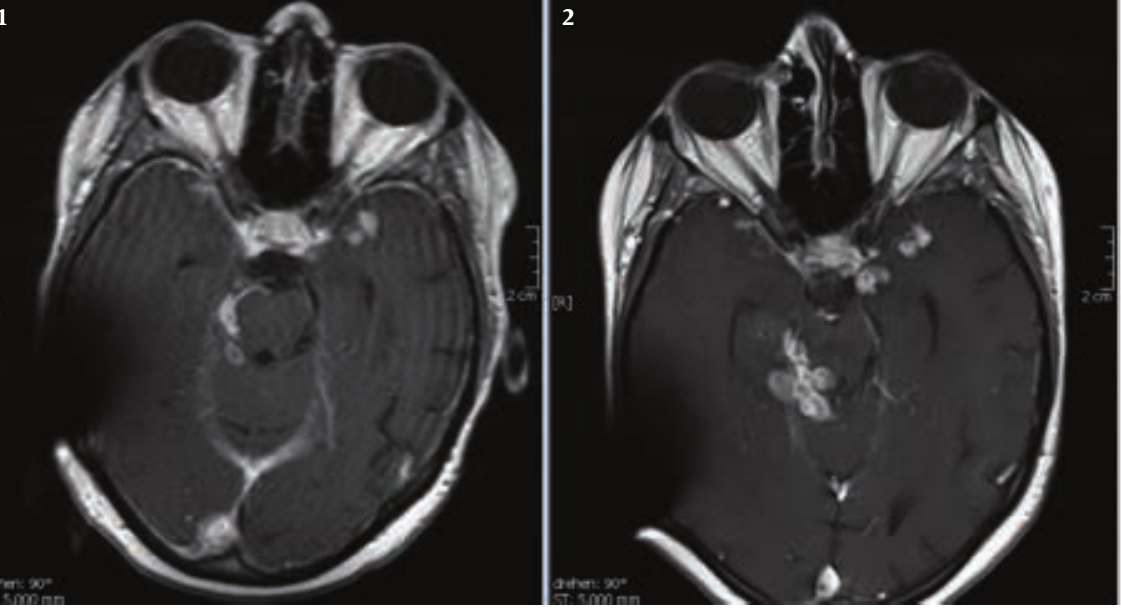
Figure 1: Cerebral MRI Scan with the follow up survey, it showed the essential progression of intracranial lesions. Artifact of V-P- Shunt system.